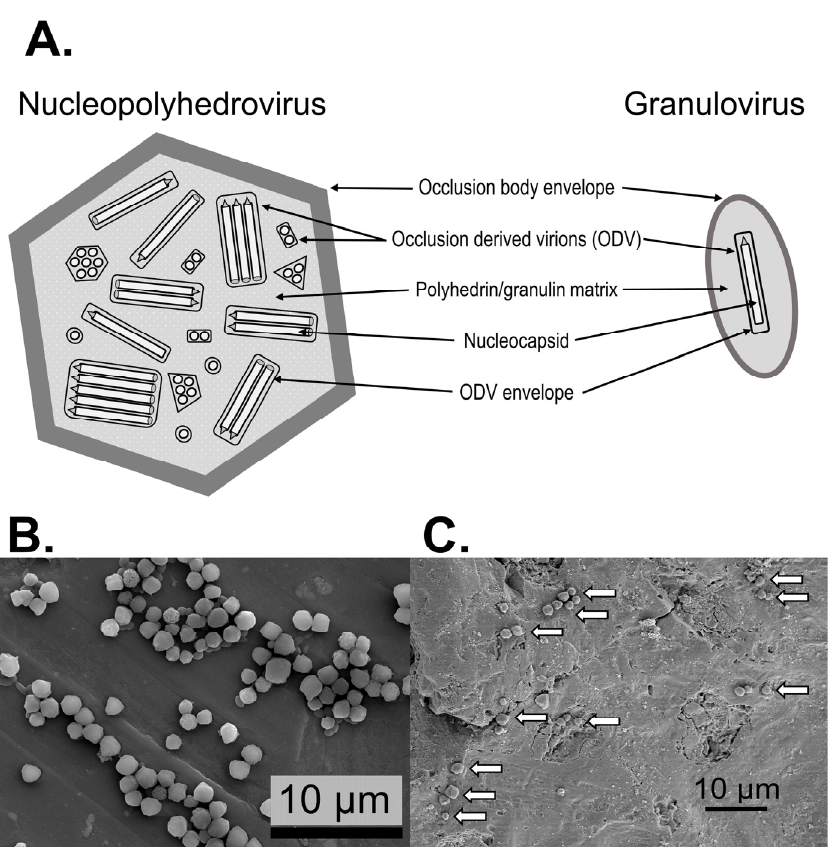
Figure 1. Morphology of baculovirus occlusion bodies (OBs). ( A ) Schematic diagram of the structure of nucleopolyhedrovirus and granulovirus OBs that infect Lepidoptera. The multi-nucleocapsid type of nucleopolyhedrovirus is shown. ( B ) Scanning electron photomicrograph of purified nucleopolyhedrovirus OBs. ( C ) Scanning electron photomicrograph of nucleopolyhedrovirus OBs adhering to a sand particle (indicated by arrowheads). Scale bars indicate 10 µm.